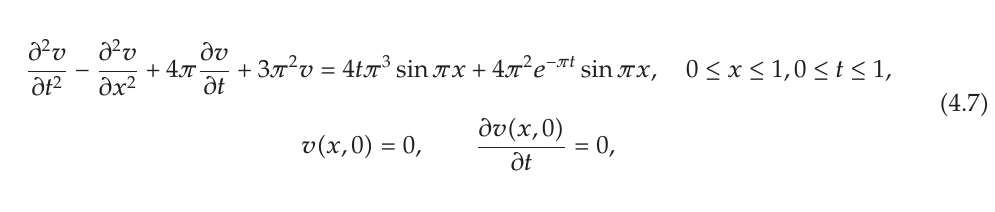
The exact solution u (cid:4) x, t (cid:5) (cid:3) e − πt sin πx . If we apply v (cid:4) x, t (cid:5) (cid:3) u (cid:4) x, t (cid:5) − sin πx (cid:2) tπ sin πx